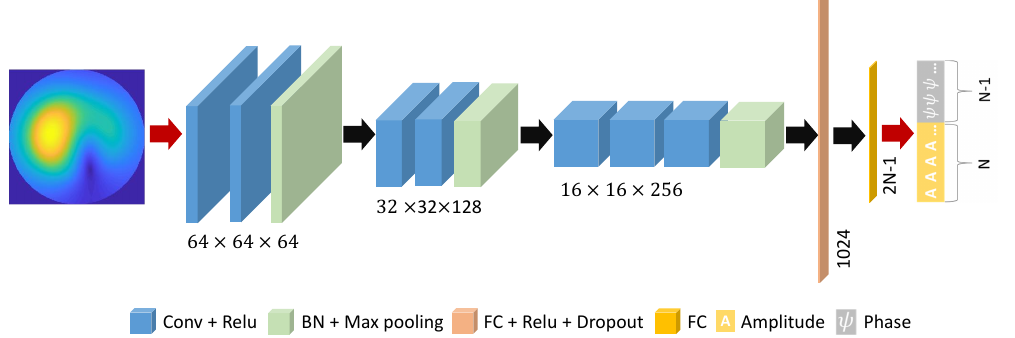
Figure 1. Architecture of the deep neural network (DNN) used to run a mode decomposition